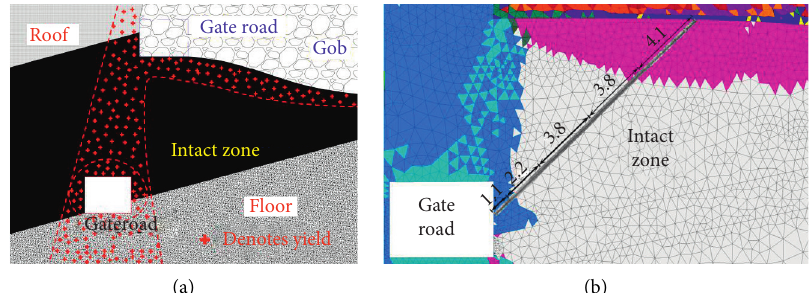
Figure 19: Speculated, numerical modelling and borehole camera field observational results comparison [35].